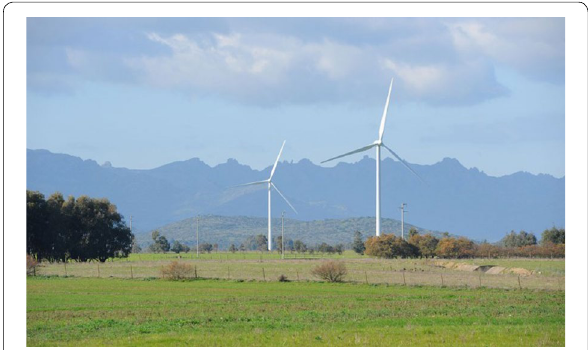
Fig. 3 Wind power plant in Villacidro (SU) (Source: